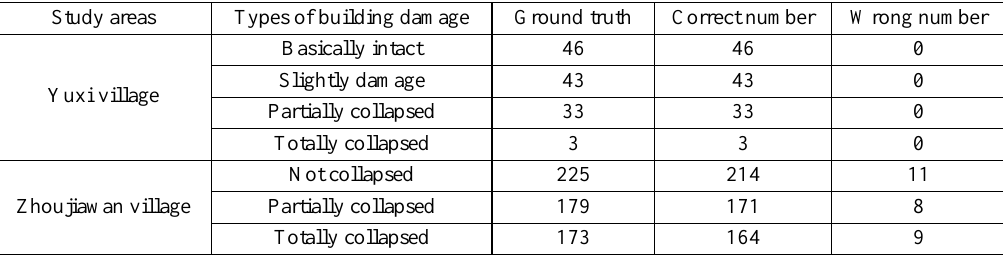
Table 2. Quantitative analysis of the results of the building damage classification